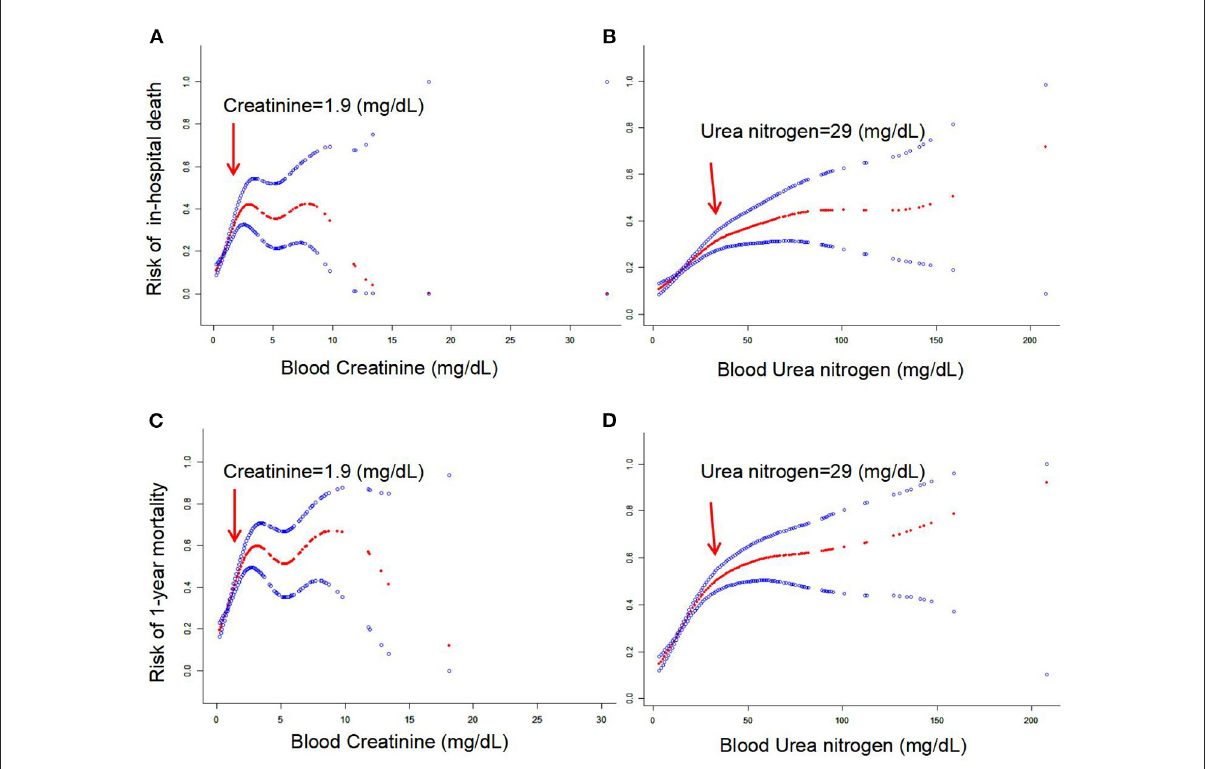
FIGURE2 (A–D) Smoothed curves of the associations between blood creatinine and urea nitrogen and mortality risk in patients with intracranial